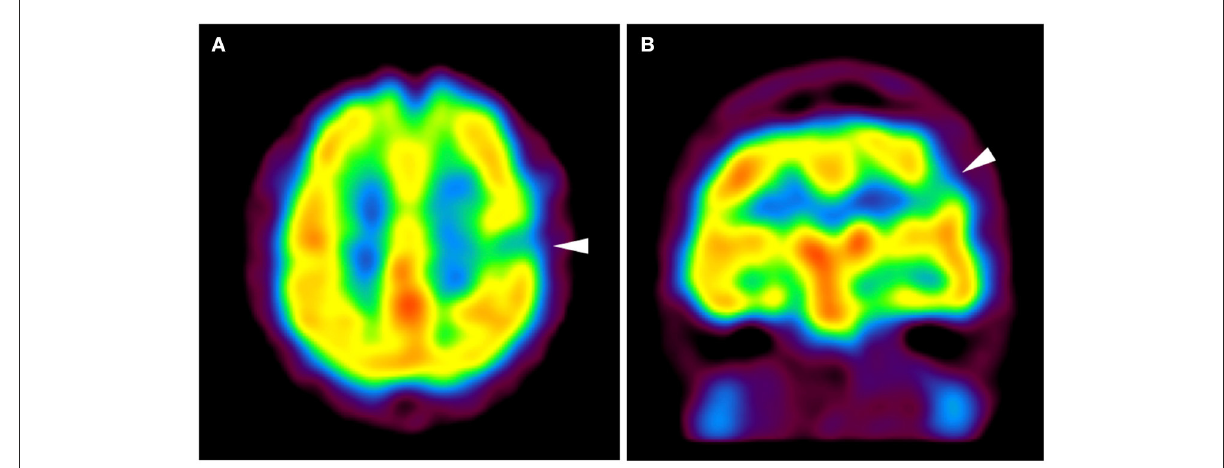
FIGURE3 Axial (A) and coronal (B) images of technetium-99m ethyl cysteinate dimer single-photon emission computed tomography show hypoperfusion in the left frontoparietal portion (arrowhead). The area of hypoperfusion appears to be concordant with the structurally abnormal gyrus shown in Figures 1,